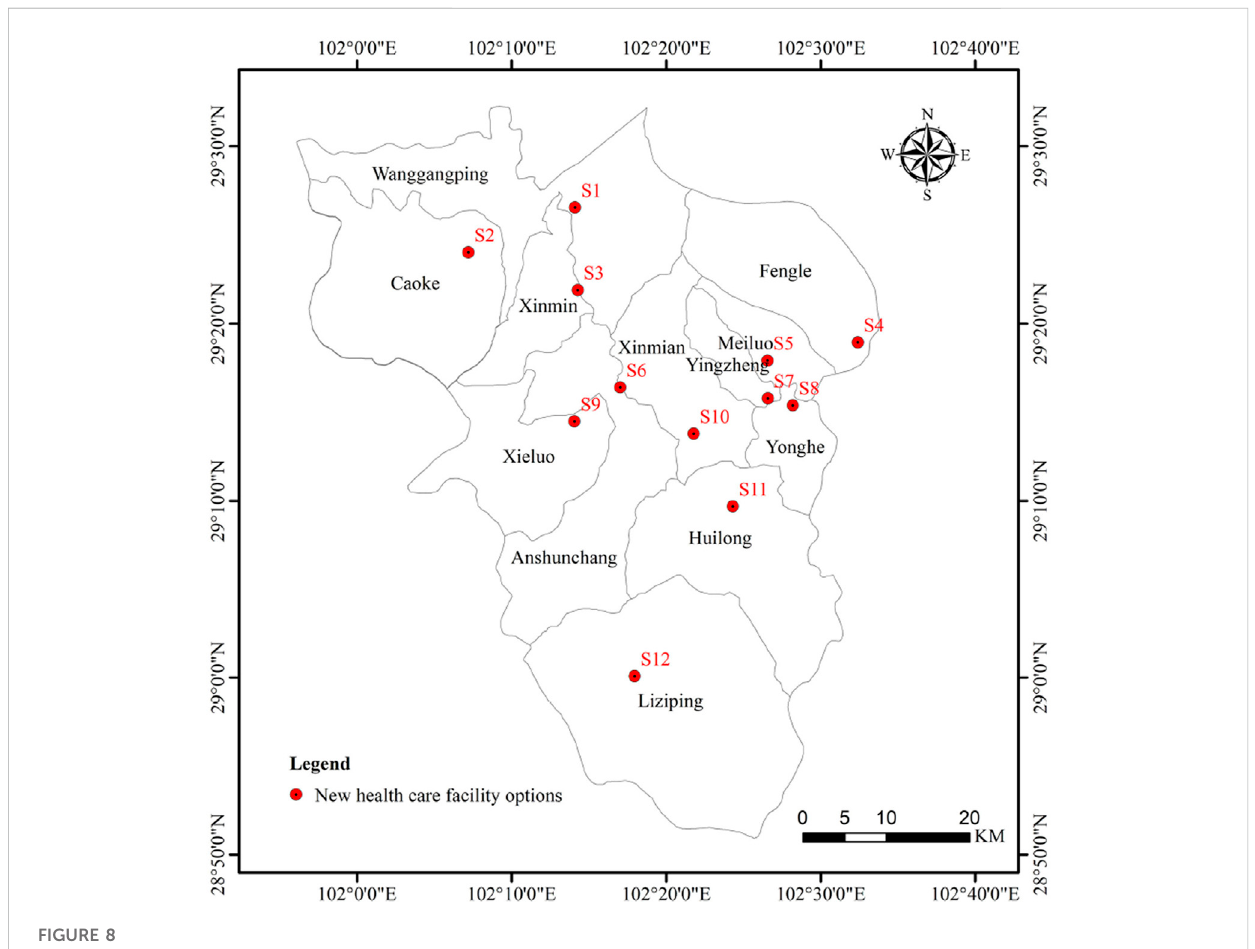
FIGURE 8 The site alternatives for new healthcare facilities.